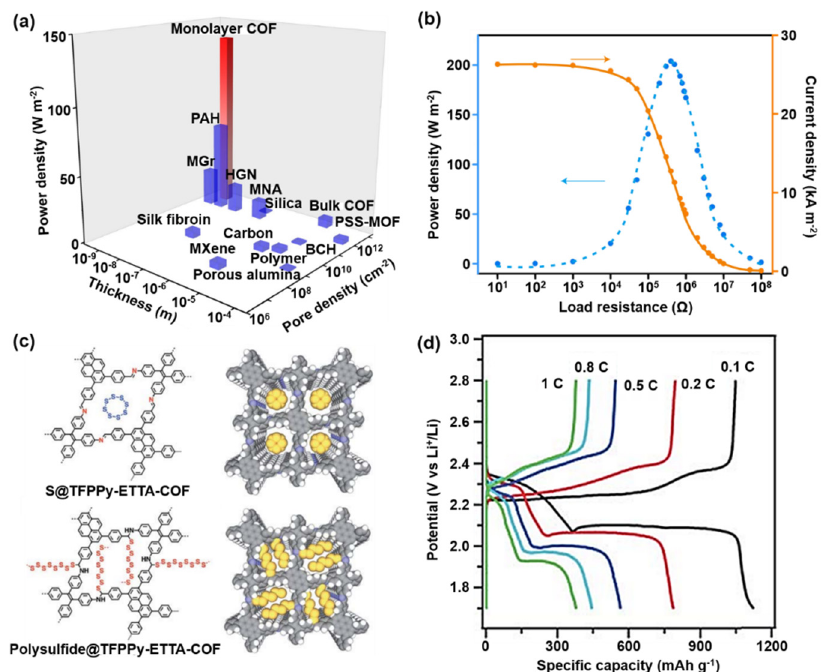
Figure 7. Enhancement of electrochemical performance by good pore structure and aligned channels. ( a ) Comparison of the osmotic power-generation performance of the COF monolayer membrane with state-of-the-art results from the literature in terms of membrane thickness, pore density and output power density. ( b ) Current density and output power density dependence on the external load resistance on mixing artificial seawater with artificial river water [116]. Copyright 2022, Springer Nature. ( c ) Physical isolation of sulfur (S 8 ring) in the COF and covalent engineering of polysulfide chains on the pore walls. ( d ) Charge-discharge curves of polysulfide@TFPPy–ETTA–COF at different rates [117]. Copyright 2019, The Royal Society of Chemistry.